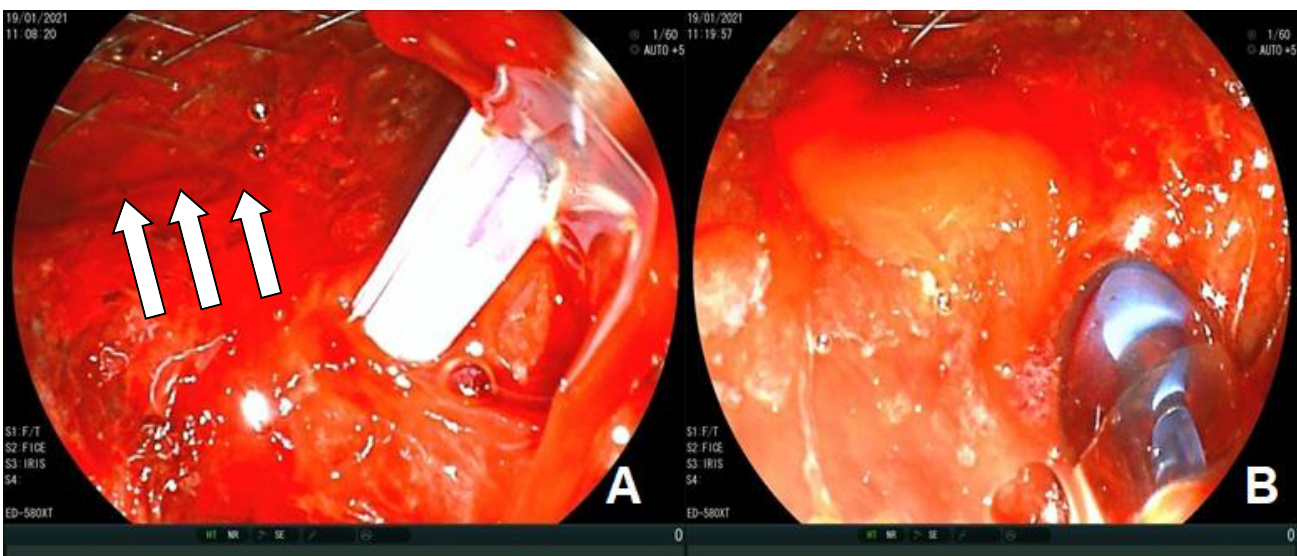
Figure 2. ( A ) Oblique MPR (Multi Planar Reconstruction) CT (Computed Tomography) image after duodenal stent placement, showing a severe dilation of the biliary tree, not present in the previous MRI exam, involving the common biliary duct. The course of the common biliary tract was grossly interrupted at the terminal end by compression of the papillary area due to the neoplastic infiltration of the stent mesh. ( B ) Oblique MPR CT image after biliary stent placement with the rendezvous approach due to the impossibility of reaching the papilla endoscopically due to tumor growth through duodenal stent’s mesh. Resolution of biliary dilatation is documented.